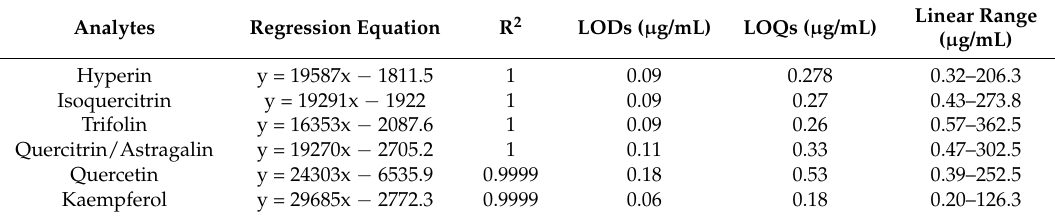
Table 3. Calibration curve, LOD and LOQ, and linear range for six